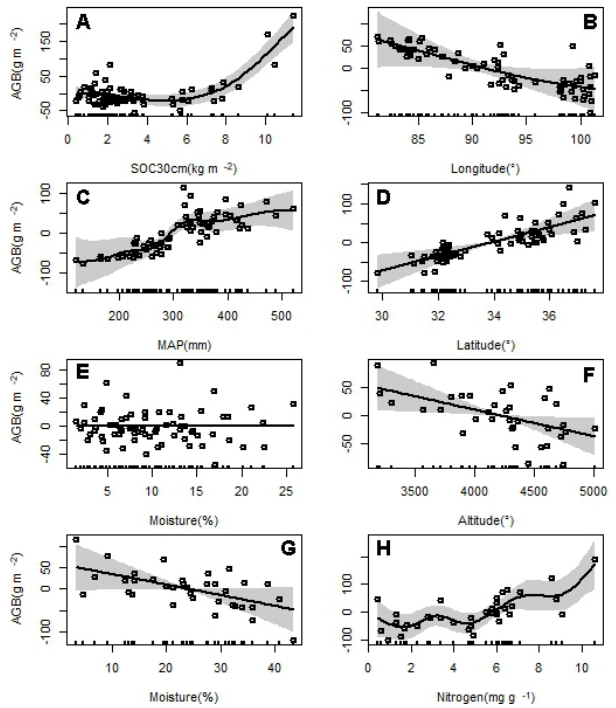
Fig. 5. Predicted changes in the alpine steppe AGB along with the major environmental factors by GAM analysis. Rugplot on the x- axis represents the observed value, and the gray belts indicate the credible intervals. Panels (A) , (B) , (C) , (D) , and (E) represent the variations of AGB with SOC30cm, longitude, MAP, latitude, and moisture, respectively, in the alpine steppe. Panels (F) , (G) , and (H) represent the variations of AGB with altitude, moisture, and nitro- gen, respectively, in the alpine meadow. All designations are the same as those in the footnotes below Table